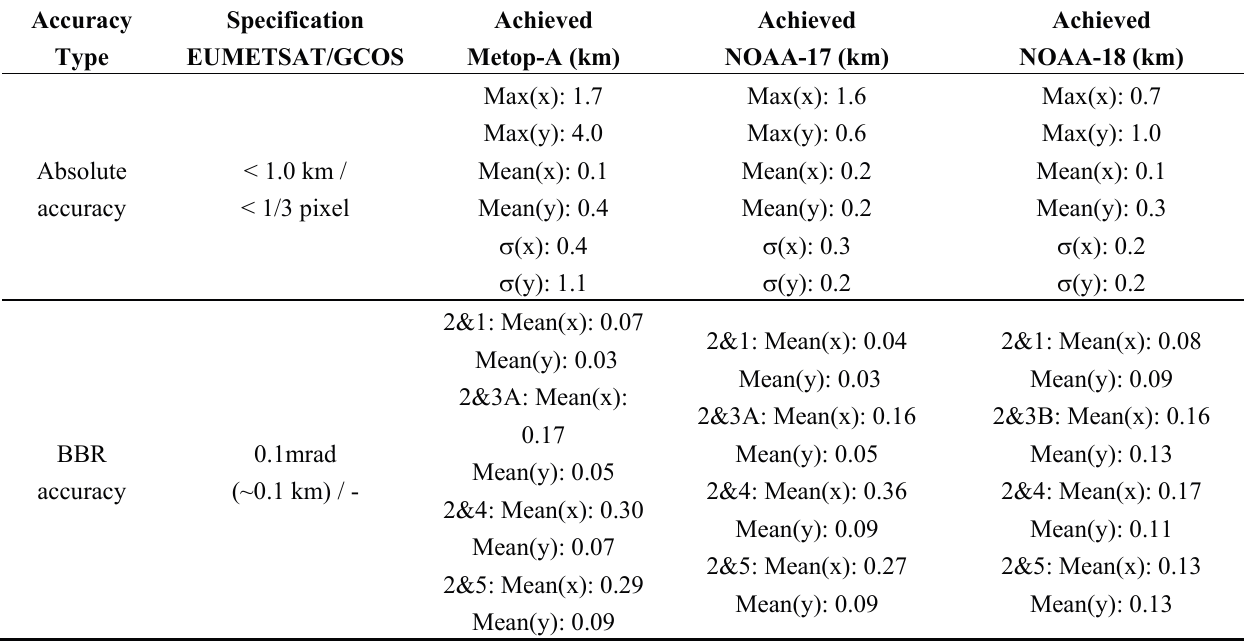
Table 11. Geometric accuracy specifications and achieved performances for AVHRR. The achieved accuracy values are presented as absolute